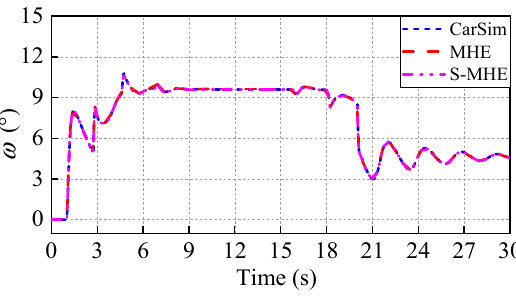
Figure 23. Yaw rate.